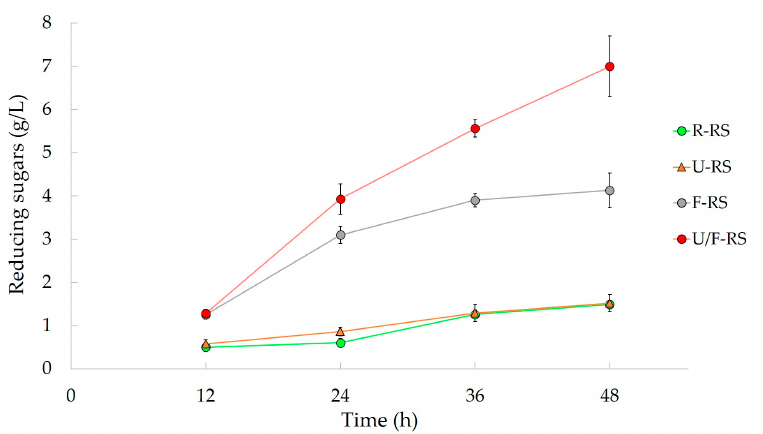
Figure 8. Reducing sugars recovered from pretreated and raw RS samples. U/F-RS = com- bined US 6Fenton process); F-RS = (conventional Fenton’s process); U-RS = (UAT-RS at 400 W); (R-RS = (raw